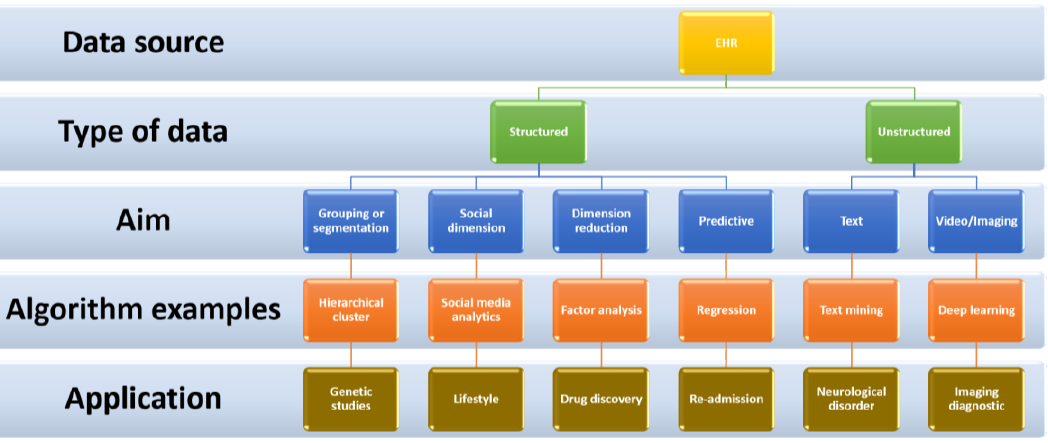
Figure 5. Electronic Health Records (EHR) workflow.